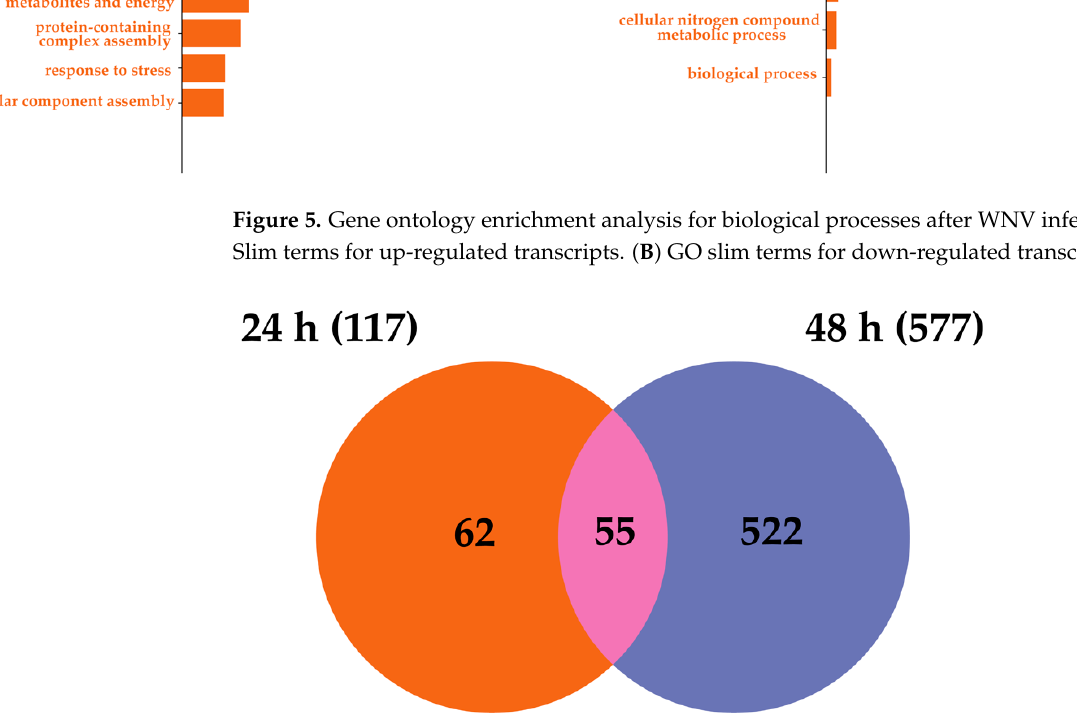
Figure 6. Venn diagram representing the number of differentially expressed transcripts at the different time points of dual-infected U4.4 cells. Timepoints 24 h and 48 h indicate time post-infection with WNV. Table 2. List of Ae. albopictus overlapping differentially expressed transcripts following LamV infec- tion and WNV challenge. Functional categories are based on GO terms for biological processes. Fold changes are shown in hours post-challenge with WNV. The cut-offs used were p -adjusted value of ≤ 0.01 and log 2 FC of ≥ 0.5.